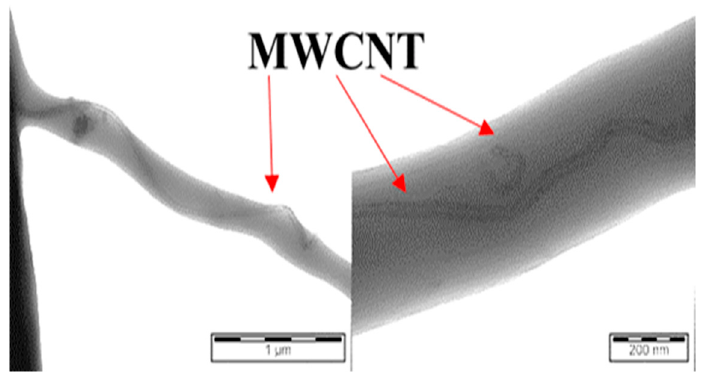
Figure 4. TEM images of EVA/3.0 wt % MWCNT.